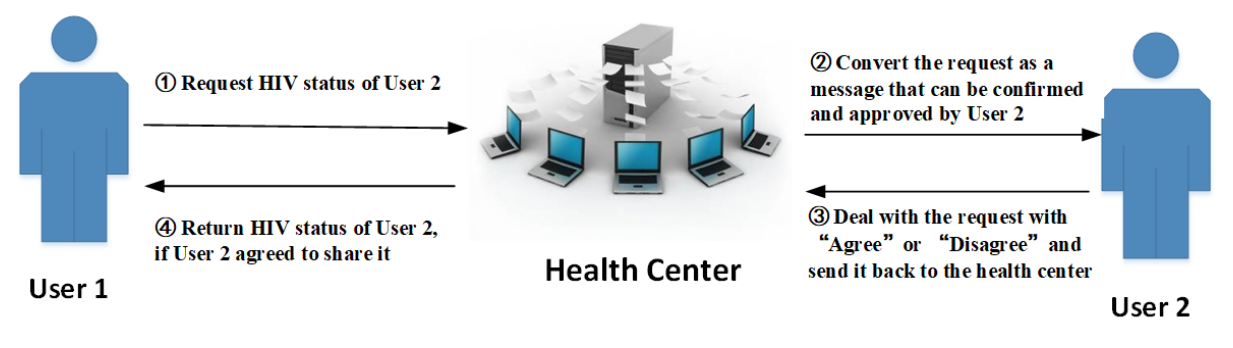
Figure 3. The interfaces of the app’s four